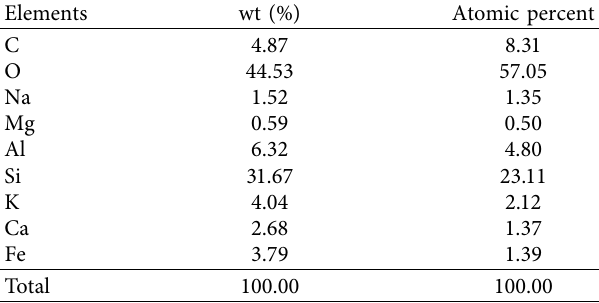
Figure 7: Epoxy resin samples with diferent k a sample stirred in air. Table 1: Elemental composition of the granite.